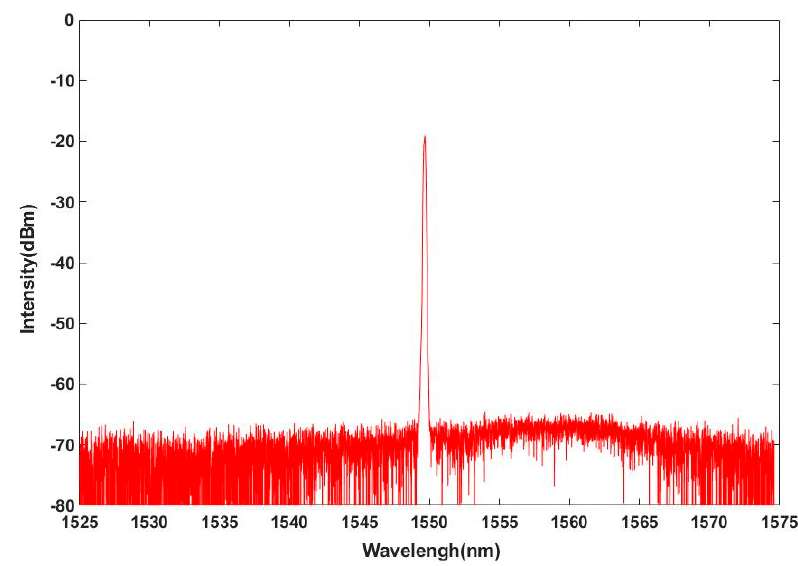
Figure 3. Output spectrum of the seed signal.